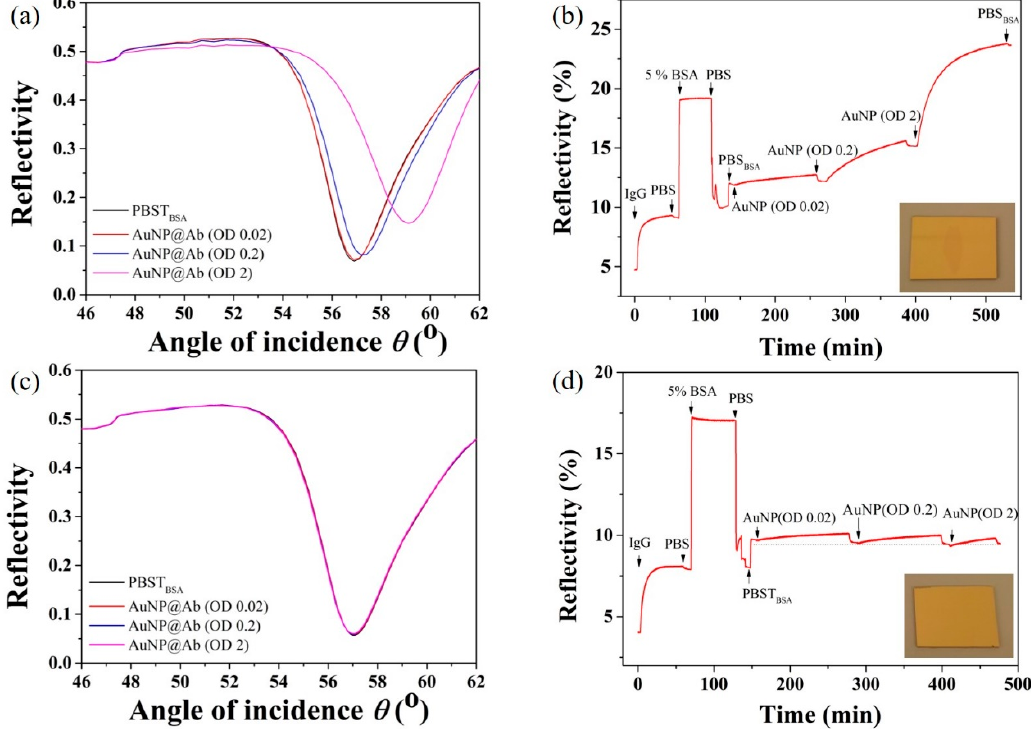
Figure 4. Validation of immune-binding assay for goat anti-mouse IgG functionalized 17 nm AuNPs on mouse anti-goat IgG SPR sensors. ( a ) Typical angular measurement as a function of AuNP concentration and ( b ) corresponding kinetic measurements; Control angular ( c ) and kinetic ( d ) measurements on goat anti-mouse IgG sensors as a function of AuNP concentration.